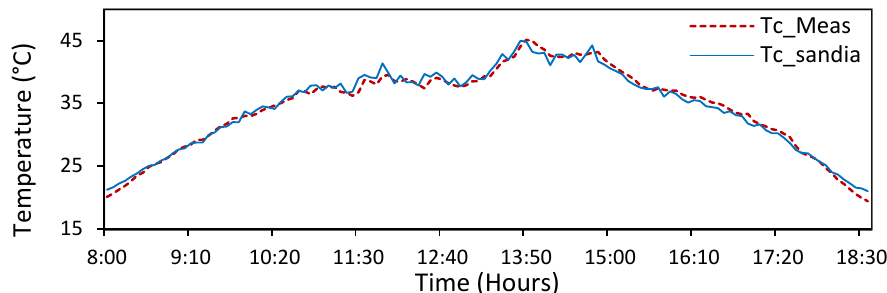
Figure 7. Measured ambient temperature, module temperature, and wind velocity.